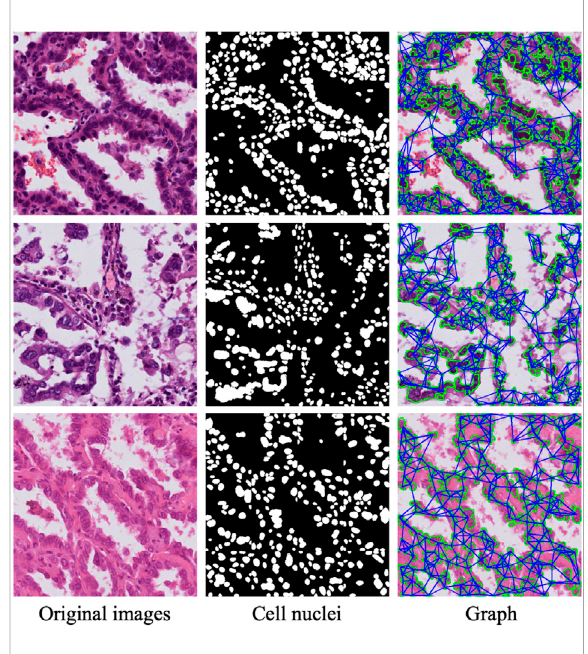
FIGURE 4 Three sample patches of cell nuclei structures. First column: typicalpatchesfromlungtumorhistopathologicalimages.Second column: nuclei segmentation mask from nuclei segmentation module. Third column: graph nodes and